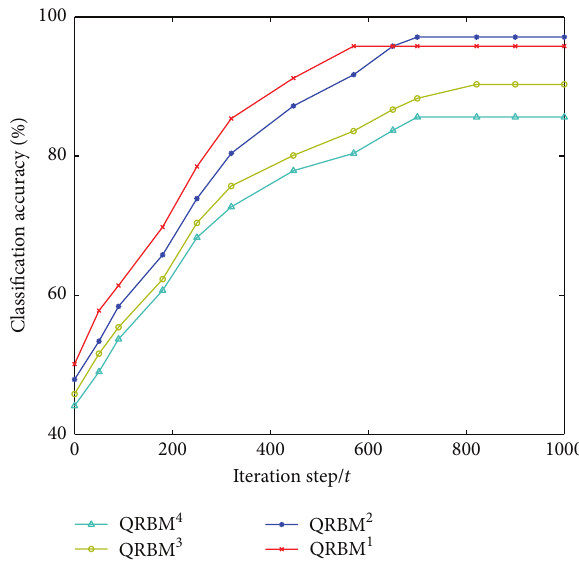
Figure 6: The comparison result with four